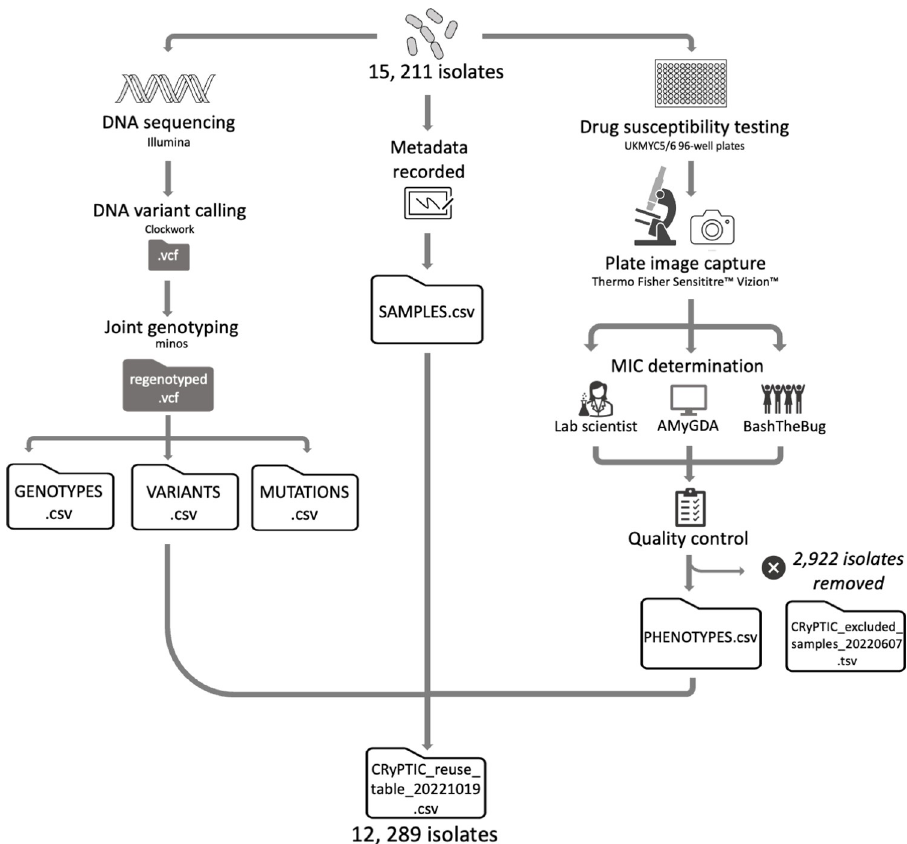
Fig 1. Processing sequencing and minimum inhibitory concentration data for 15,211 Mycobacterium tuberculosis isolates (“full” dataset). Briefly: Each isolate was DNA sequenced using an Illumina machine and plated onto 96-well plates (UKMYC5/6) containing 5–10 × doubling dilutions of 13 antitubercular drugs for DST. Associated metadata (including country of origin and processing laboratory) was recorded. DNA variant calling and analysis was performed using Clockwork and Minos [47]). After 14 days, MIC measurements were taken by a trained scientist using Vizion, and the plate was photographed to also measure the MIC using the automated AMyGDA software and citizen scientists from BashTheBug [45]. After quality control procedures, phenotypic MIC data for 2,922 isolates were removed. The compendium therefore contains 15,211 isolates with WGS data (“full dataset”), 12,289 of which have matched quality assessed phenotypic data (“data compendium”). The raw sequence, VCFs, MICs, and binary resistance calls for the data compendium are presented in “CRyPTIC_reuse_table_20211019.csv” via an FTP site (see Methods), and the raw sequence and VCF files for those samples present in the full dataset are presented in “CRyPTIC_excluded_samples_20220607.tsv” via the same FTP site (see Methods). The data tables GENOTYPES.csv, VARIANTS.csv, MUTATIONS.csv, SAMPLES.csv, and PHENOTYPES.csv used for the analyses presented in this manuscript are also accessible via the FTP site (see Methods). DST AU : AbbreviationlistshavebeencompiledforthoseusedinFigs 1 and 3 (cid:0) 6 : Pleaseverifythatallentriesarecorrect : , drug susceptibility testing; MIC, minimum inhibitory concentration; WGS, whole-genome